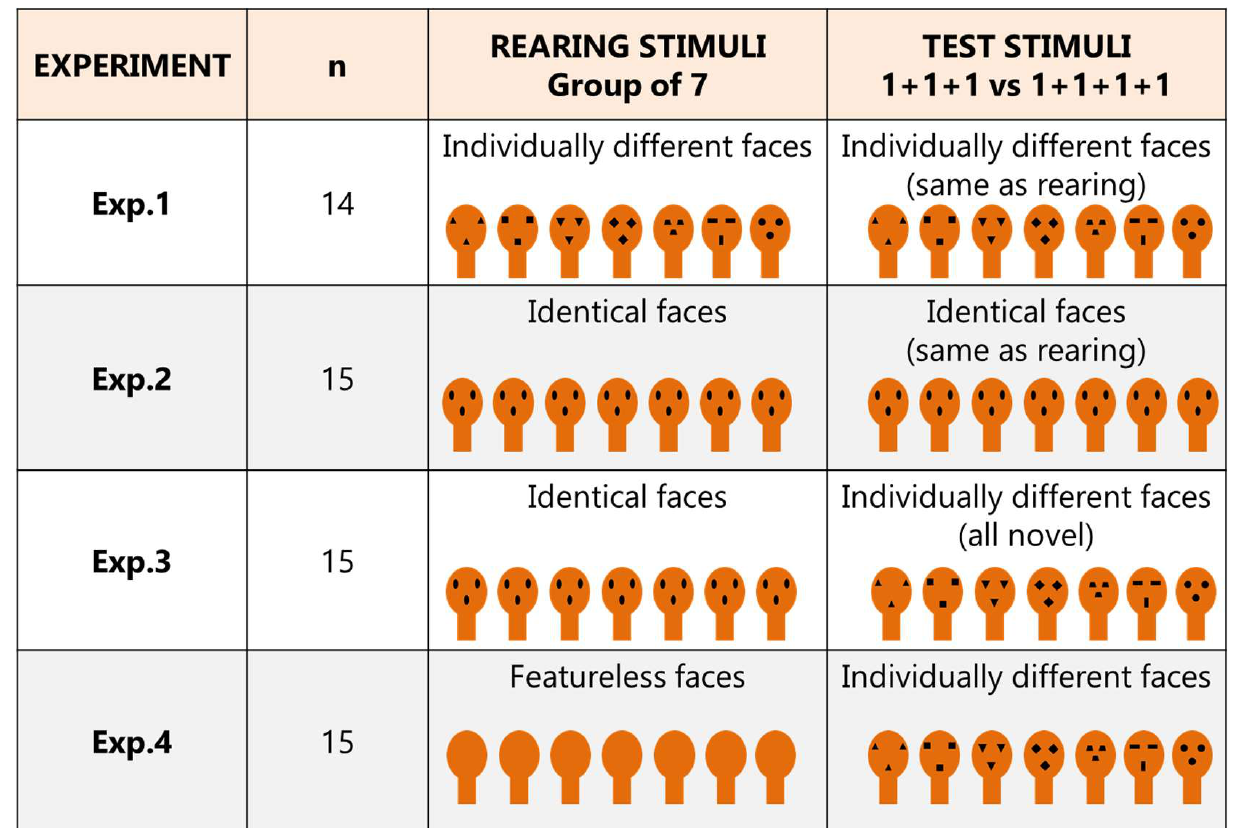
Figure 3. Visual summary of the procedures and sample size for each experiment. In Exp. 1, fourteen chicks were reared and tested with a set of seven individually different faces; in Exp. 2, fifteen chicks were reared and tested with a set of seven identical faces; in Exp. 3, fifteen chicks were reared with a set of seven identical faces and tested with a novel set of seven individually different faces; in Exp. 4, fifteen chicks were reared with featureless silhouettes and tested with a set of seven individually different faces.